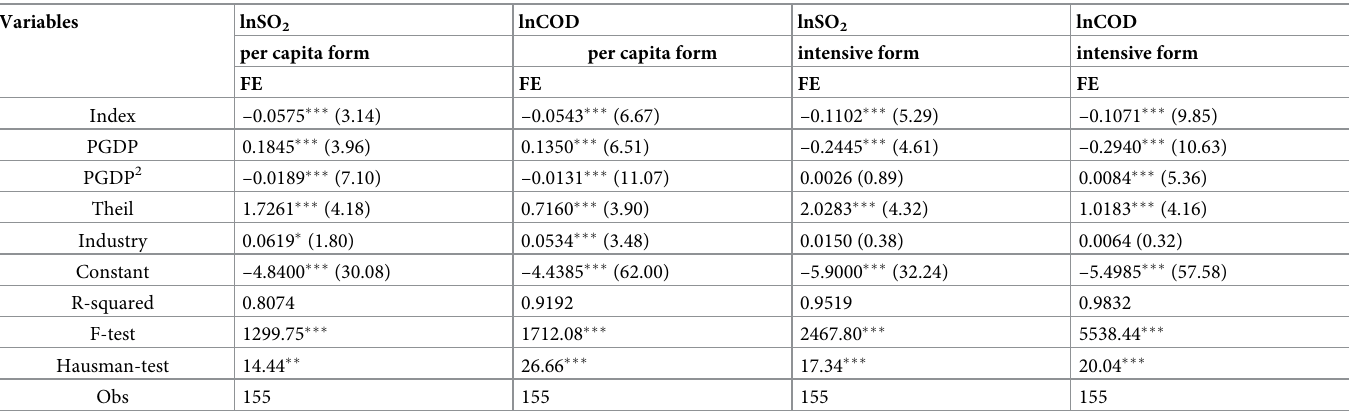
Table 3. Regression results of per capita form and intensive